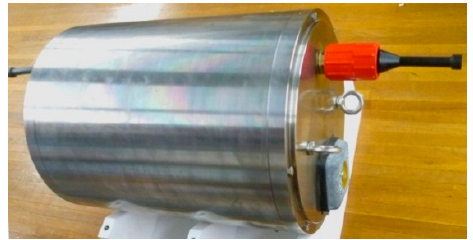
Figure 9. External view of the battery module.